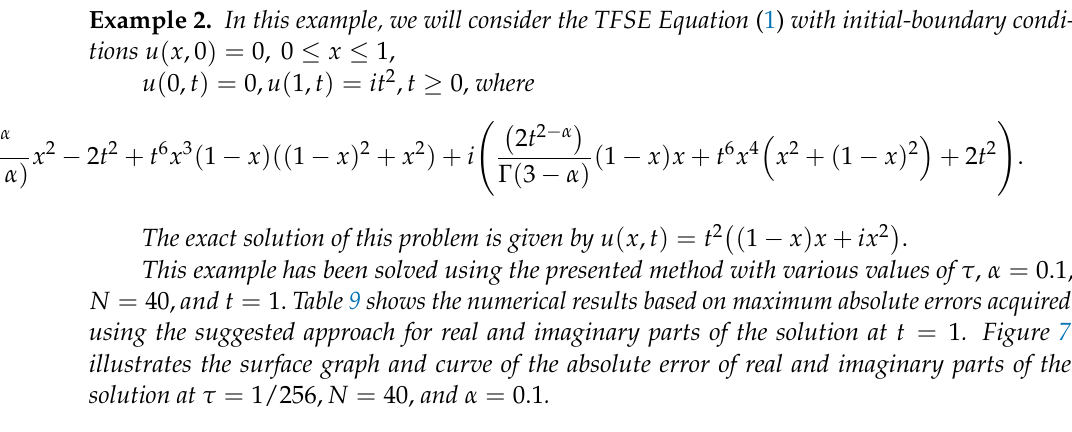
Figure 6. Error graph of R and S in Equation (1) for α = 0.6, α = 0.2, α = 0.01, respectively, τ = 0.0025, a = 0, b = 1, N = 25 and t = 0.5.